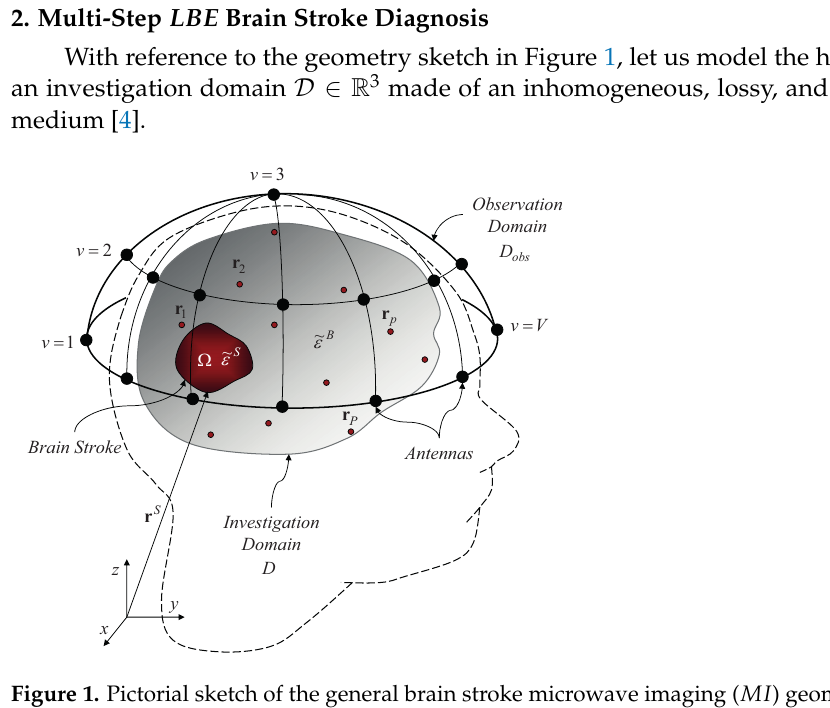
Figure 1. Pictorial sketch of the general brain stroke microwave imaging ( MI )